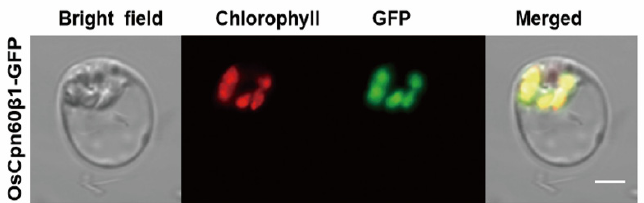
Figure 6. Subcellular localization of the OsCpn60 β 1-GFP (green fluorescent protein) in rice protoplasts. GFP signals show that the OsCpn60 β 1-GFP fusion protein produced from the 35S::OsCpn60 β 1-GFP construct localized to the chloroplast. Green fluorescence shows GFP, red fluorescence shows chloroplast auto- fluorescence and yellow fluorescence shows the merged fluorescence. Scale bar, 5 μ m.